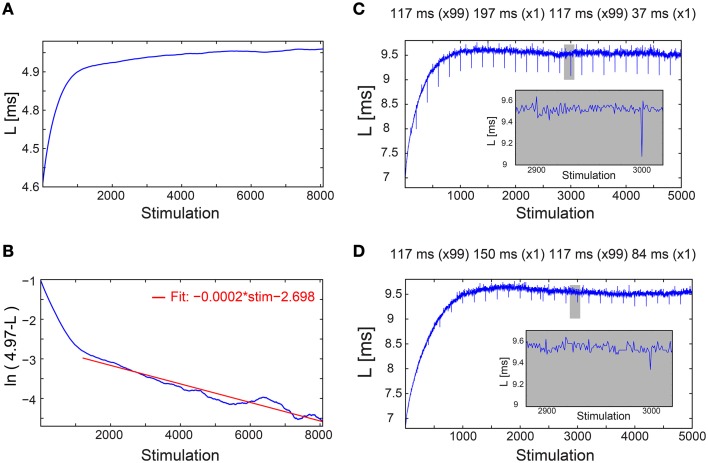
Convergence of the neuronal response latency to stabilization without adaptive external feedback, and asymmetry between facilitation and depression. (A) The NRL, L, of a cultured neuron stimulated at τ = 198.2 ms between stimulations (blue), with an estimated LST of 4.97 ms (Figure 1C, middle panel), smoothed using 1000 Stimulation sliding window. (B) ln (LST-L) using the estimated LST (blue). The fit in the range of [1200, 8073] stimulations (red) indicates a convergence to LST as LST-L~0.06·exp(−0.0002·Stimulation). (C) The NRL, L, of a neuron stimulated at τ = 117 ms between stimulations, where at stimulations (2n + 1)·100 τ = 197 ms and at (2n + 2)·100 τ = 37 ms, where n,1,.… Results indicate an asymmetry between facilitation, with an amplitude of ~0.4 ms in case τ decreased, and depression, with an amplitude of ~0.1 ms in case τ increased (see zoom-in, gray). (D) Same as (C) but with moderate changes in τ, at stimulations (2n + 1)·100 τ = 150 ms and at (2n + 2)·100 τ = 84 ms. Results indicate an asymmetry between facilitation, with an amplitude of ~0.2 ms in case τ decreased, and depression, with an amplitude of ~0.1 ms in case τ increased (see zoom-in, gray).